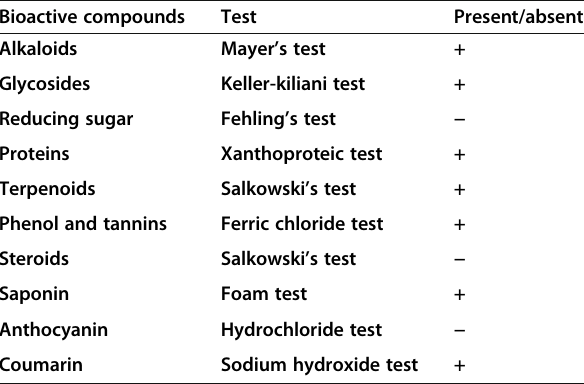
Table 1 Phytochemical screening for bioactive compounds